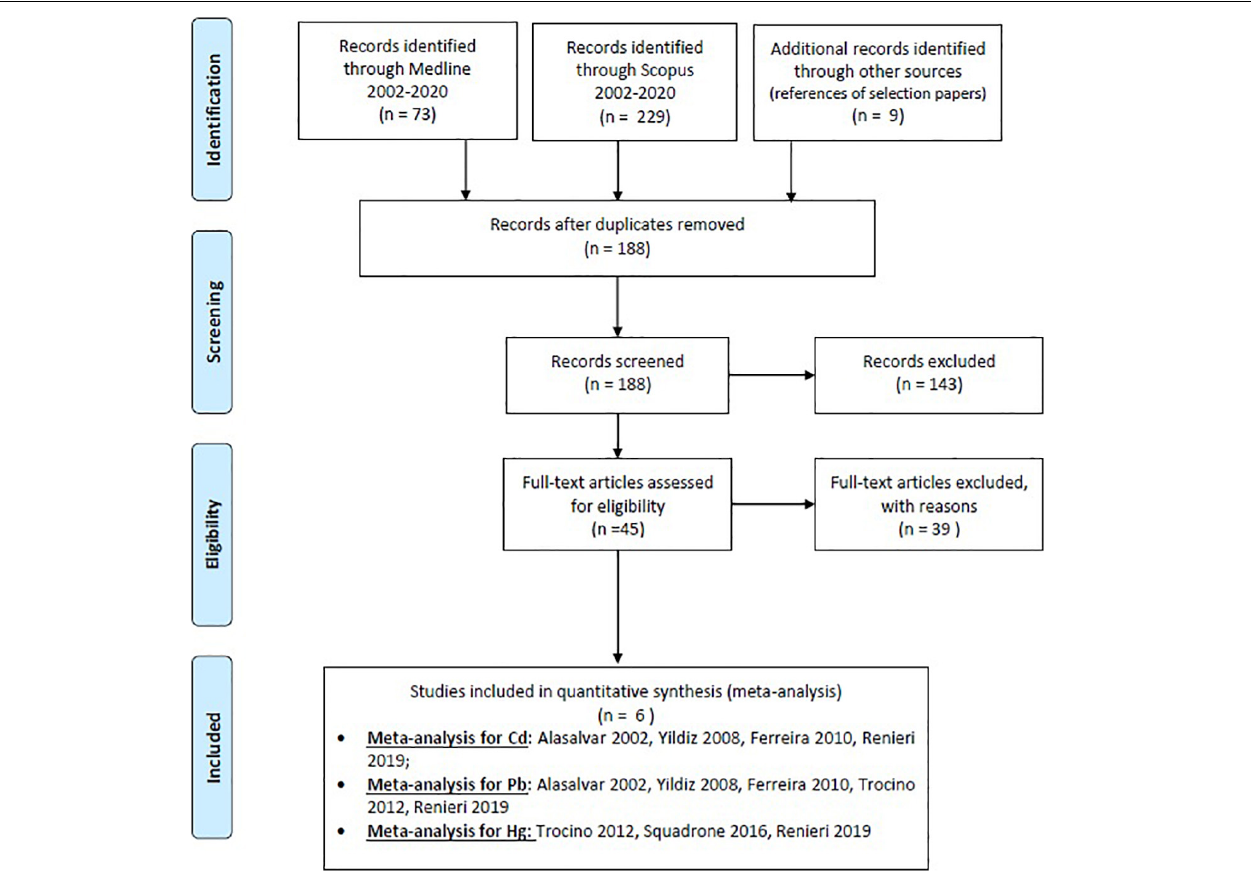
FIGURE 1 | Preferred Reporting Items for Systematic Reviews and Meta-Analyses (PRISMA)—flow diagram for study